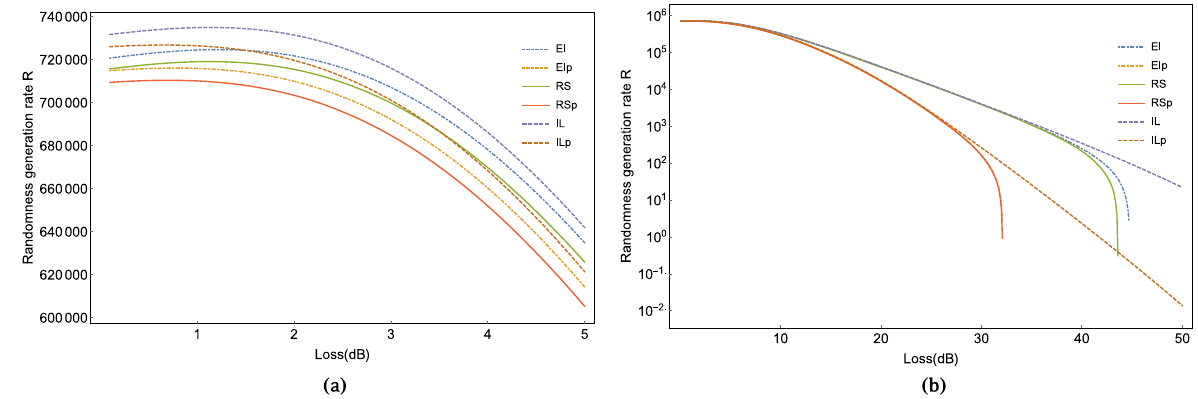
Fig. 5 Optimal randomness generation rates as a function of the loss of VOA with different values of ^ p α and error estimation methods including random sampling (RS), entropy inequality (EI) and in fi nite length (IL). RS, EI, and IL represent the models without the afterpulse and RSP, EIP, and ILP represent the models with the afterpulse ^ p α ¼ 5 % . The experimental parameters are listed in Table 1, and we assume that the pulse distribution is the coherent state that contains ν = 50 photons initially. a The condition with low loss. b The condition with the loss of up to 50 dB.